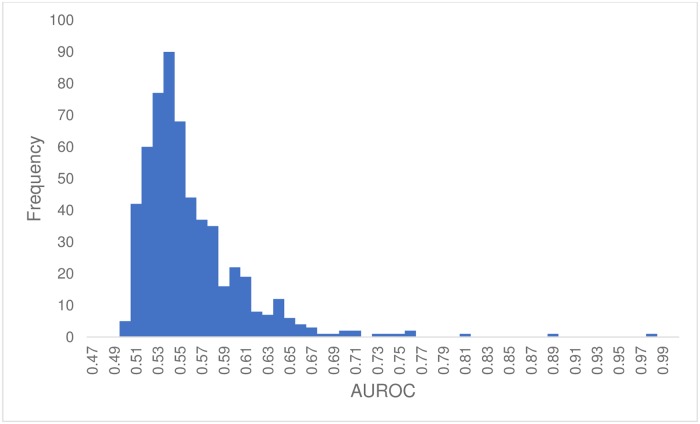
Histogram of the G-WIZ predicted AUROCs of the 569 studies from GWAS Central.Bin width of 0.01.